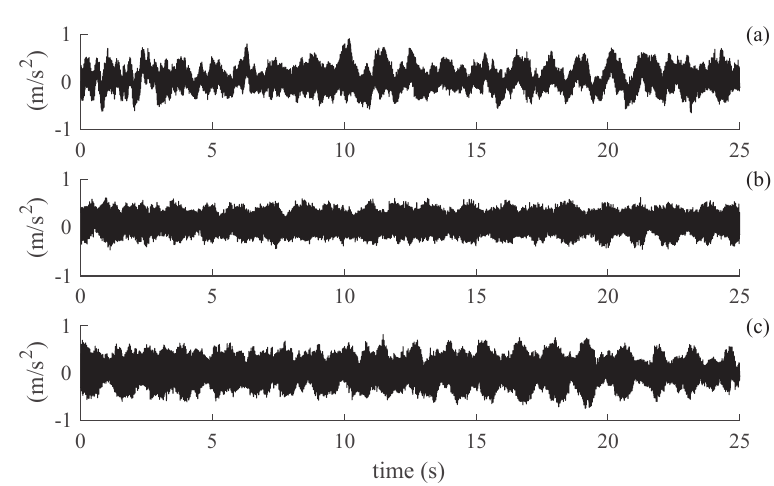
Figure 9. Raw vibration signals referenced to ( a ) Time Series 5 (TS5), ( b ) TS6 and ( c ) TS8. Table 3. Working condition of turbine SGM11 during TS recording.